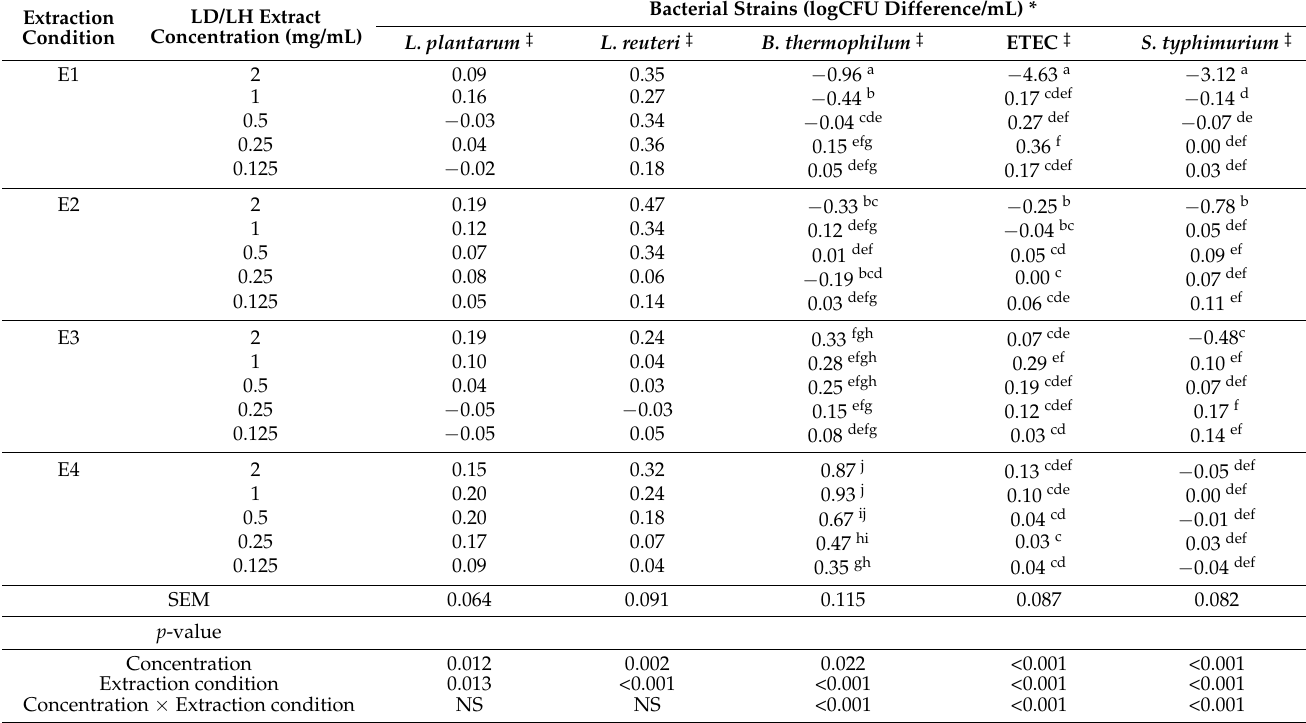
Table 8. Effects of extraction conditions and increasing concentrations of L. digitata and L. hyperborea extracts on the counts of selected beneficial and pathogenic bacterial strains in the pure-culture growth assays (least-square means and standard error of the